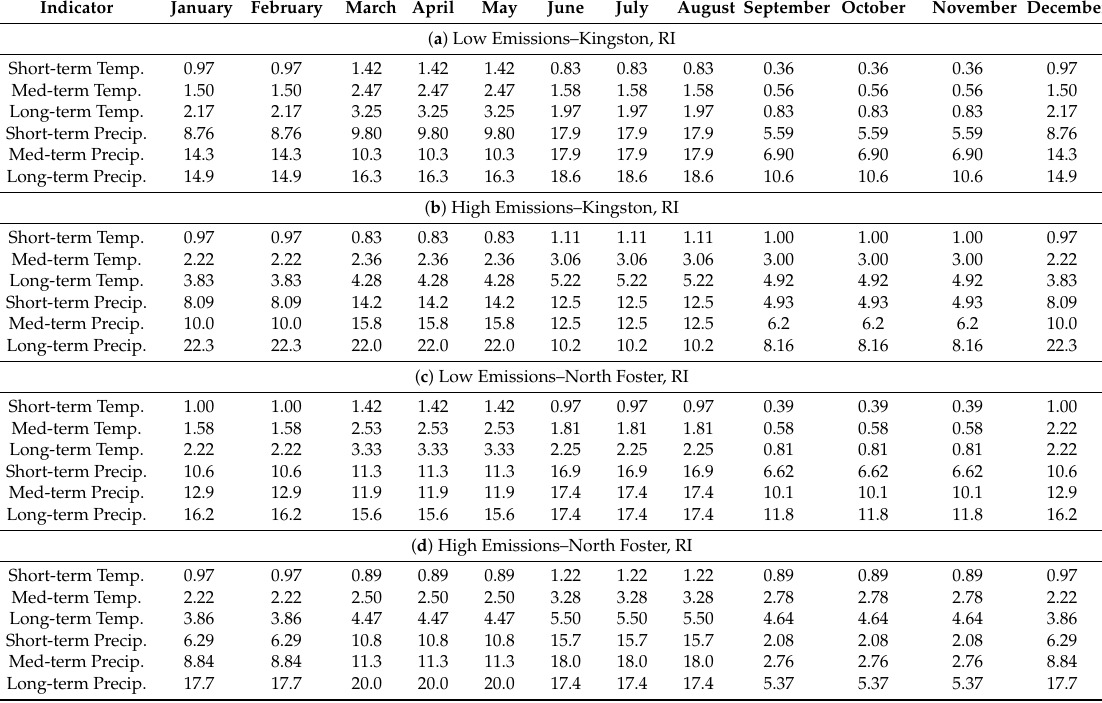
Table 4. Climate change variables adopted and modified from Wake et al., 2014 [27] for ( a , b ) Kingston, RI (Beaver River and Queen River) and ( c , d ) North Foster, RI (Cork Brook). Low emissions ( a , c ) based on SRES A1fi scenario and high emissions ( b , c ) based on SRES B1 scenario. Temperatures (Temp.) listed as degree ( ◦ C) increase, averaged from the published minimum and maximum temperatures. Precipitation (Precip.) values listed as a relative change computed based on the published